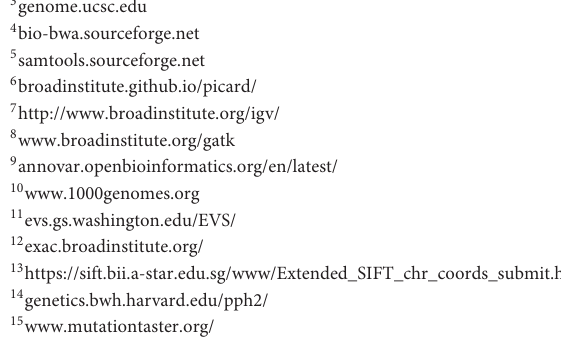
FIGURE 6 | AGXT mutations on Chinese population. Novel mutations identified in the present study are labeled by red “